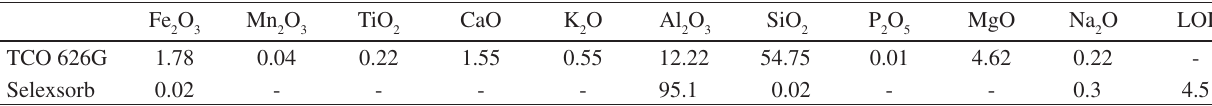
Table 1. Chemical Composition of the Adsorbents (% m/m).